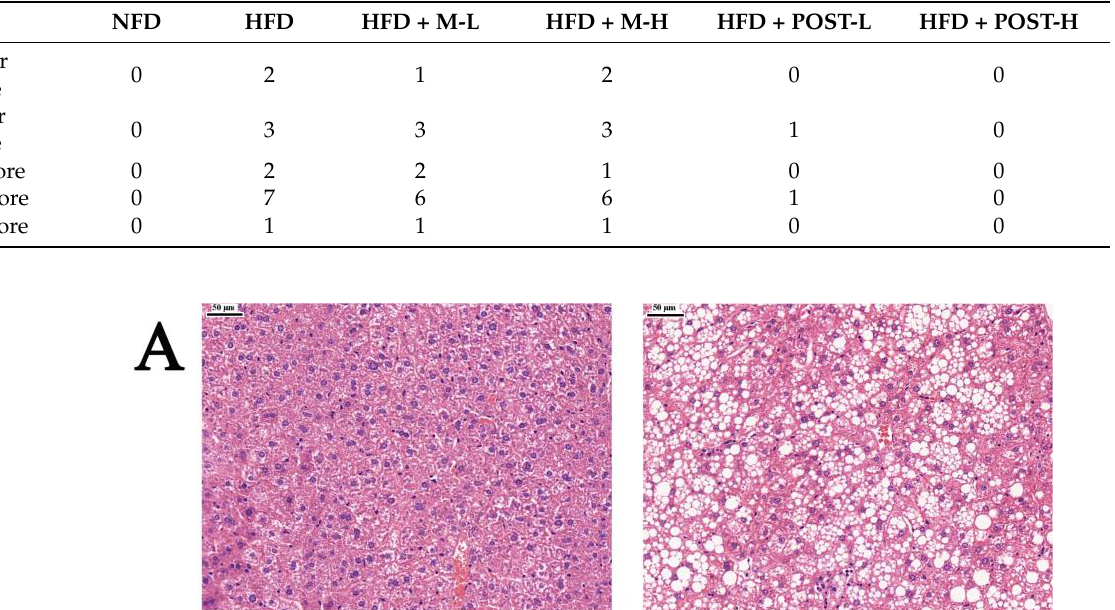
Table 1. Steatosis and inflammation scores of livers.